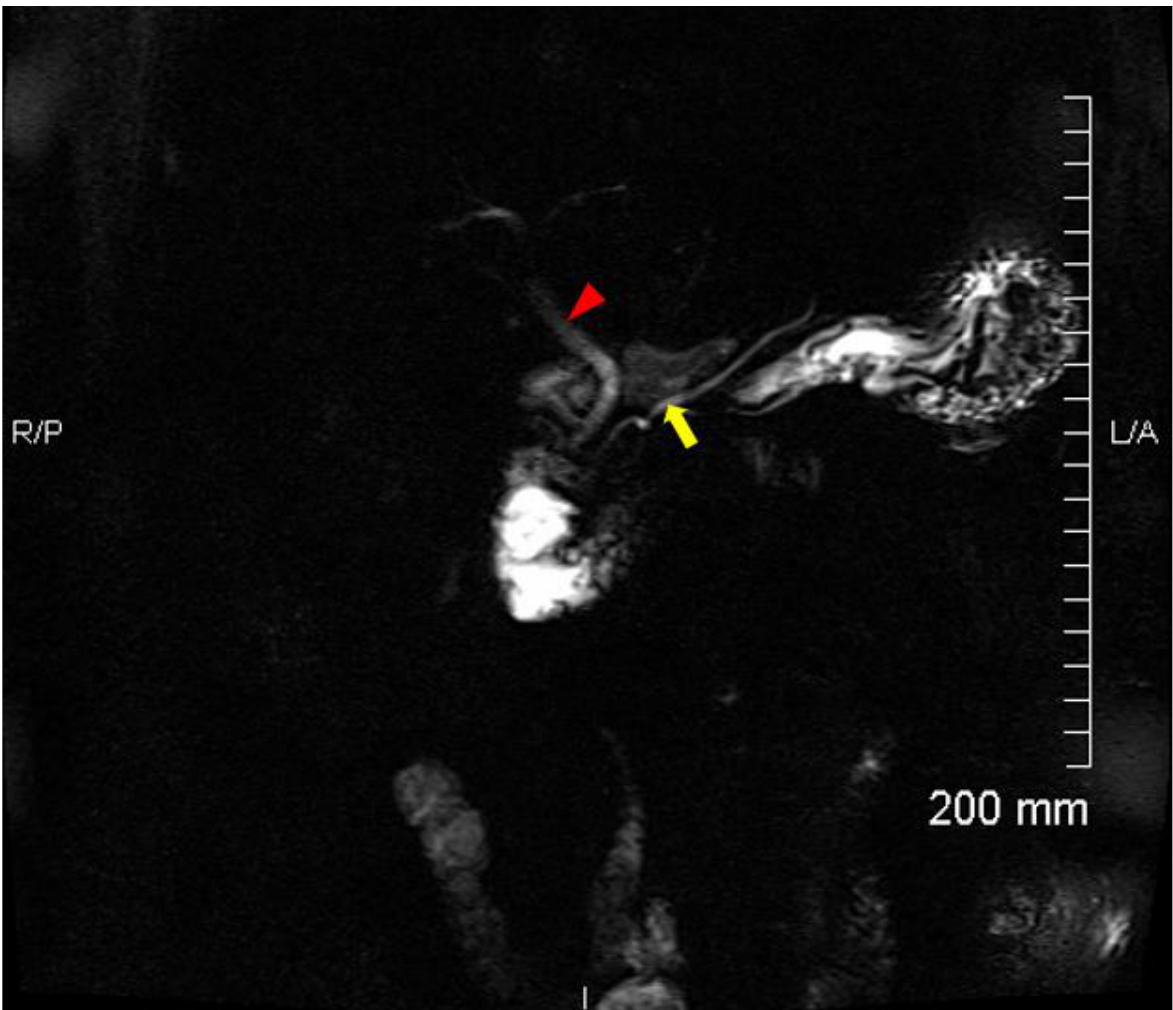
Figure 3. A follow-up MRCP 9 days after the 18 F-FDG PET shows no evidence of acute cholangitis or acute pancreatitis. Coronal T2 weighted MIP imaging (SSTSE, slice thickness 30 mm) shows the CBD (arrow head) and main pancreatic duct (arrow). No lesions or abnormal findings within the CBD. The size of the CBD measures 6 mm.